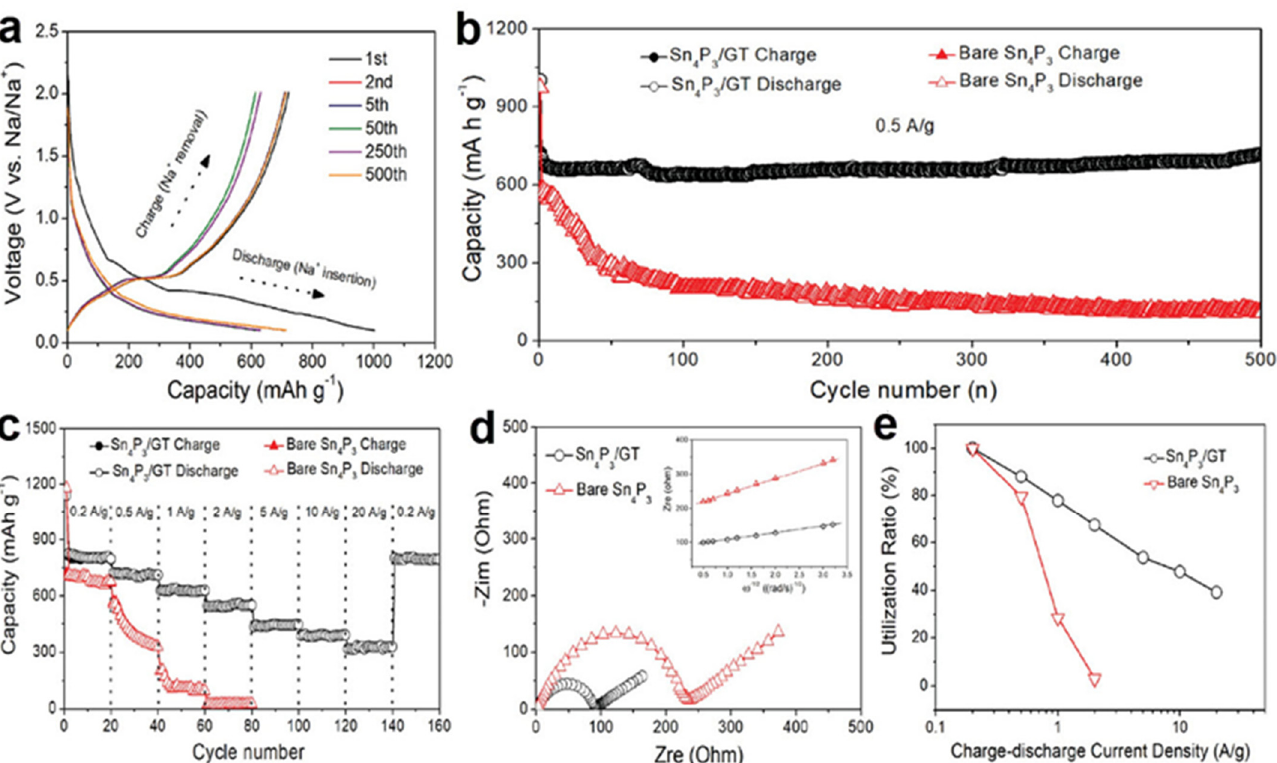
Figure 17. ( a ) GCD curves of Sn 4 P 3 /GT for the 1st, 2nd, 5th, 50th, 250th, and 500th cycles with the voltage window of 0.01–2 V versus Na/Na + at 0.5 A g − 1 ; the comparison of electrochemical properties between the electrode of Sn 4 P 3 /GT and bare Sn 4 P 3 : ( b ) GCD cycling tests at 0.5 A g − 1 , ( c ) rate capability under different current densities for 500 cycles, ( d ) Nyquist plot, Inset of ( d ) shows the relationship between ω –1/2 (where ω is the angular frequency in the low-frequency region, ω = 2 π f) and the real part of the impedance spectra (Z re ), ( e ) Utilization radio of the active material at different GCD current densities. Reproduced with permission [58]. Copyright 2021, Wiley-VCH.